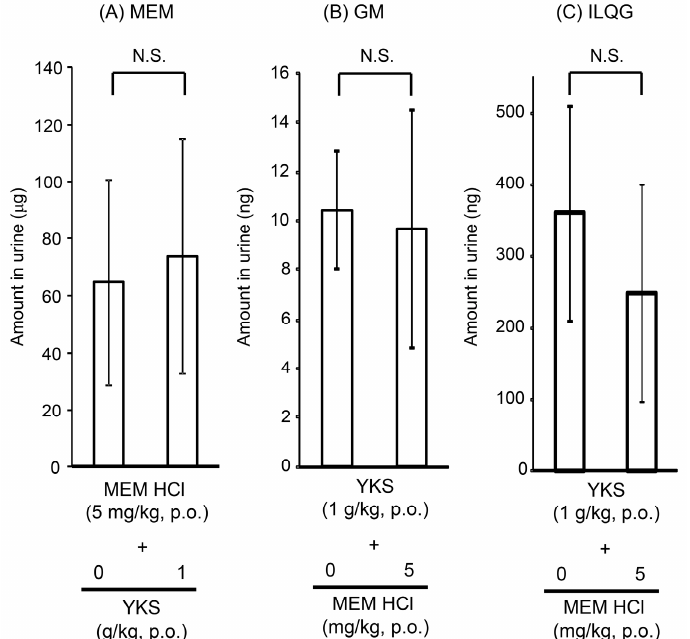
Figure 2. Excretion of MEM ( A ), GM ( B ), and ILQG ( C ) in urine from mice after oral administration of MEM, YKS, or their combination. Urine samples were collected for 24 h after administration of MEM hydrochloride (5 mg/kg), YKS (1 g/kg), or their combination in fasted mice. Data represent mean ± standard deviation ( n = 4,5). No statistical significances were observed between MEM or YKS group and the combination group (Student’s t -test).